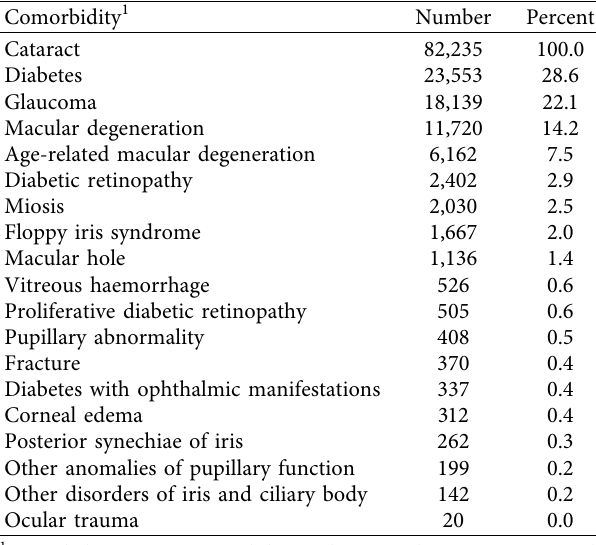
Table 1: Demographic characteristics of patients with cataract diagnosis in the Medicare fee-for-service